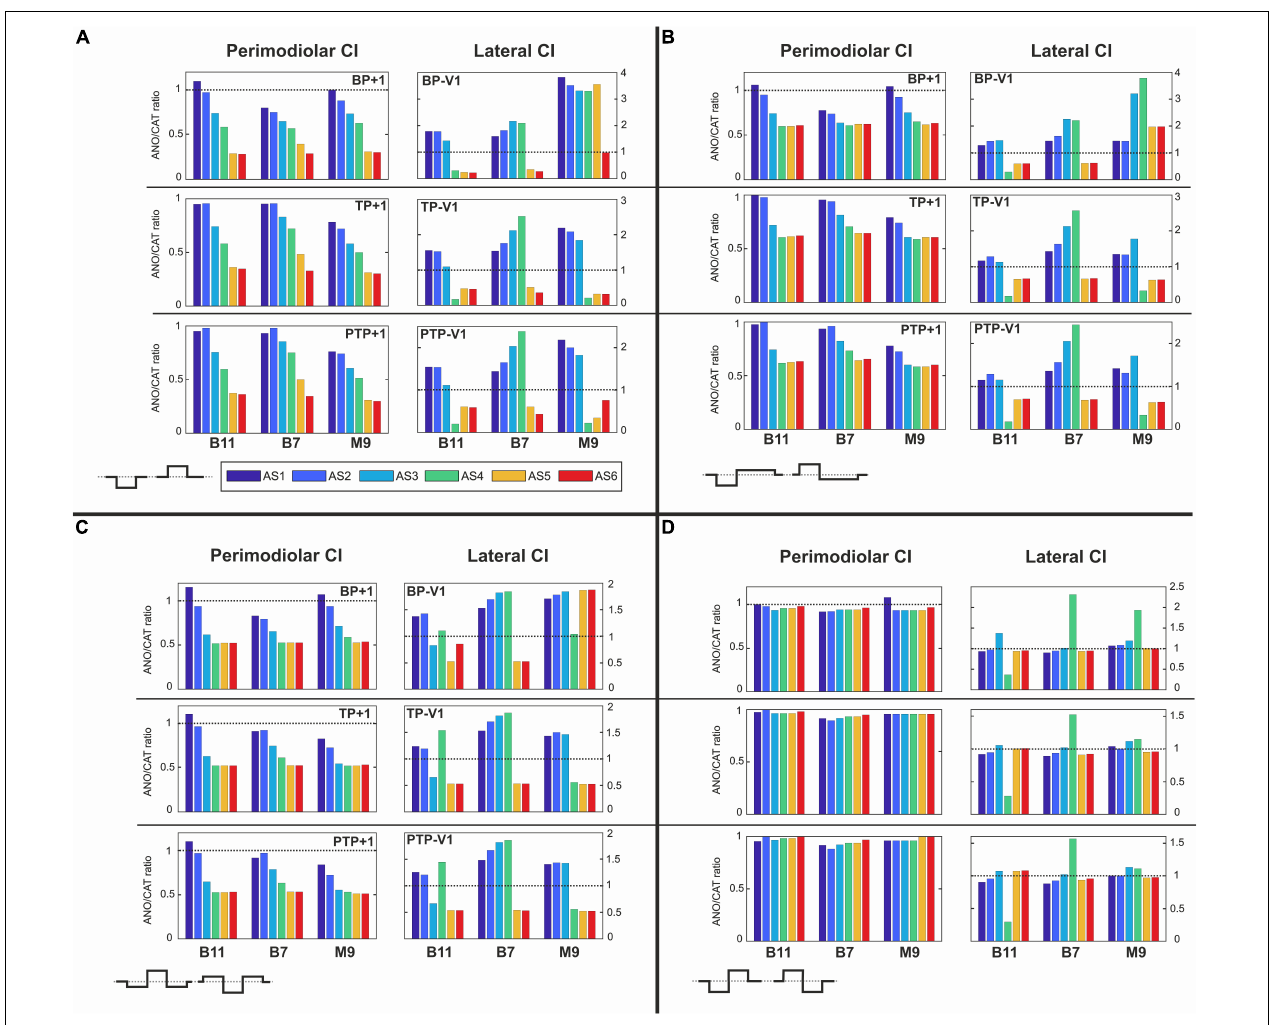
FIGURE 13 | Polarity ratios for different degeneration levels stimulated with (A) monophasic, (B) pseudomonophasic, (C) triphasic, and (D) biphasic pulse by changing the distance between channels of both CI systems. The horizontal dotted lines show the polarity ratio is equal to one (ANO/CAT = 1). Legend in (A) applies to all